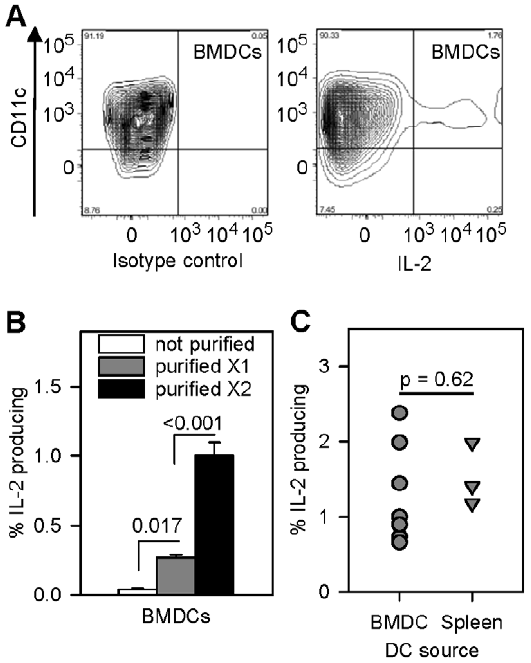
Figure 2. A small subpopulation of dendritic cells secrete IL-2 protein. A: CD11c + dendritic cells contain IL-2 protein. DCs were stained for intracytoplasmic IL-2 as in materials and methods. Panels show FACS contour plots of BMDCs stained with anti-IL-2 (right) or isotype control antibody (left). The experiments were repeated with similar results. B: Progressive purification of CD11c + dendritic cells enriches for IL-2 producing cells. The frequency of spontaneous IL-2 secreting BMDCs was measured by IL-2 ELISPOT assay as in materials and methods. Bars show mean 6 SE of % IL-2-producing cells in triplicate samples of unpurified, 1X and 2X MACS-purified CD11c + BMDCs. Statistical analysis was by one-way repeated measures ANOVA and Tukey’s test for all pairwise multiple comparison procedure. C: Dendritic cells were doubly-purified and the percentage of IL-2- producing bone marrow-derived DCs ranged from 0.7 to 2.4% (N=7), and the percentage of IL-2-producing splenic-derived DCs ranged from 1.2 to 2.0 (N=3).